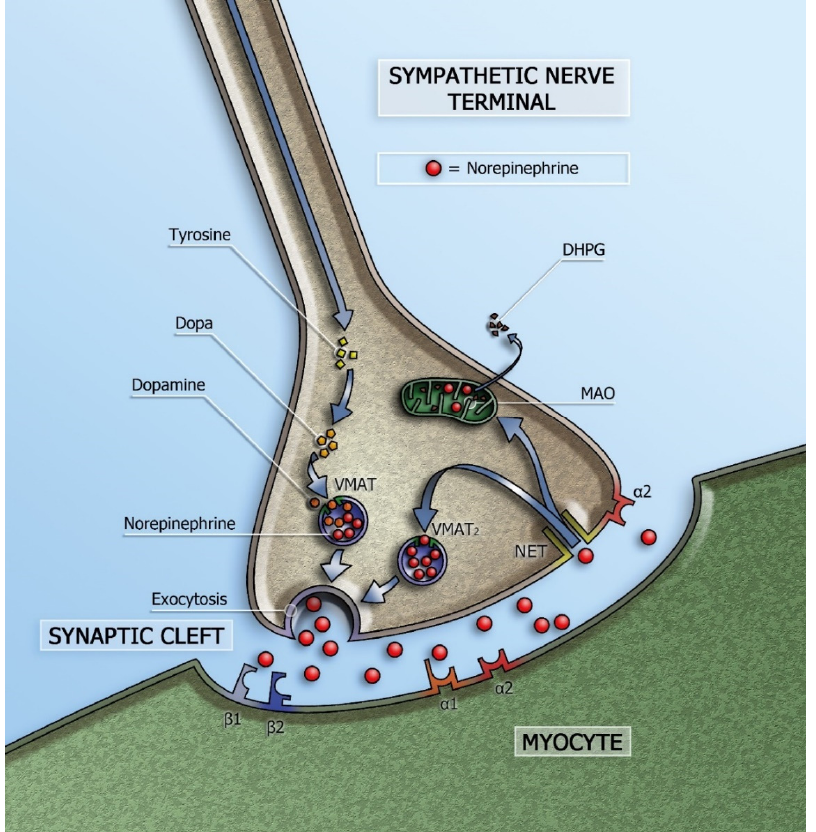
Figure 1. Schematic representation of the sympathetic synapse. Norepinephrine is synthesized within neurons by an enzymatic cascade. Dihydroxyphenylalanine (DOPA) is generated from tyrosine and subsequently converted to dopamine by DOPA decarboxylase. Dopamine is transported into storage vesicles by the energy-requiring vesicular monoamine transporter (VMAT). Norepinephrine is synthesized by dopamine β -hydroxylase within these vesicles. Neuronal stimulation leads to norepinephrine release through fusion of vesicles with the neuronal membrane (exocytosis). Apart from neuronal stimulation, release is also regulated by a number of presynaptic receptor systems, including α 2–adrenergic receptors, which provide negative feedback for exocytosis. Most norepinephrine undergoes re-uptake into nerve terminals by the presynaptic norepinephrine transporter (NET) and is re-stored in vesicles (following uptake by vesicular amine transporter 2 (VMAT2)) or is metabolized in cytosol dihydroxyphenylglycol (DHPG) by monoamine oxidase (MAO). (Adapted from Verschure et al. [1]. In CHF, the increased cardiac sympathetic activity is caused by an increased release of NE into the synaptic cleft. In addition, NE re-uptake via the NET is decreased resulting in elevated synaptic levels of NE. These elevated NE levels result in a spillover into the left ventricular dysfunction [2,3]. Initially, increased post-synaptic β -AR stimulation by NE excess has detrimental effects on myocardial structure and eventually leads to down- regulation and decrease in sensitivity of post-synaptic β -AR with downstream effects on